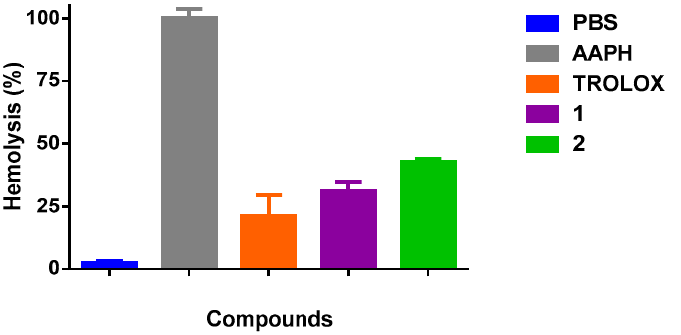
Figure 4. Percentage of hemolysis inhibition induced by 2,2'-Azobis(2-amidinopropane) dihydrochloride (AAPH) in erythrocytes of Rattus norvegicus. PBS: Phosphate Buffered Saline.